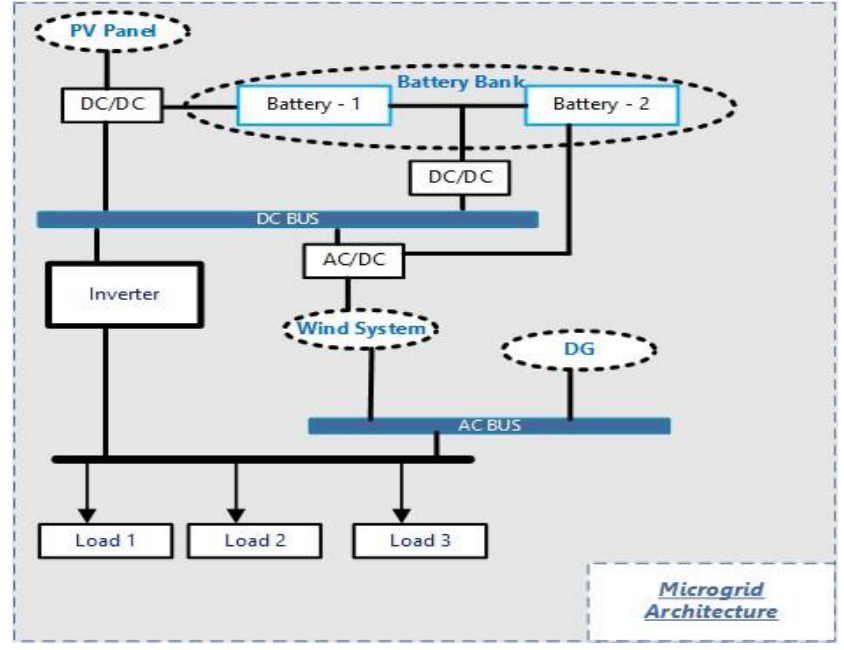
Figure 1 . Micro-grid